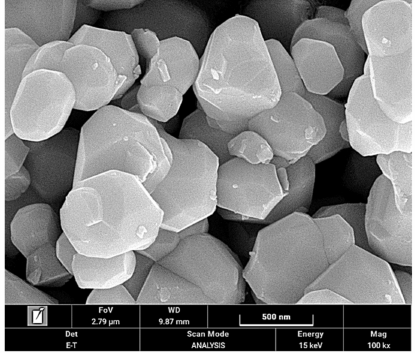
Figure 1. SEM image of as-received Nd 2 Fe 14 B